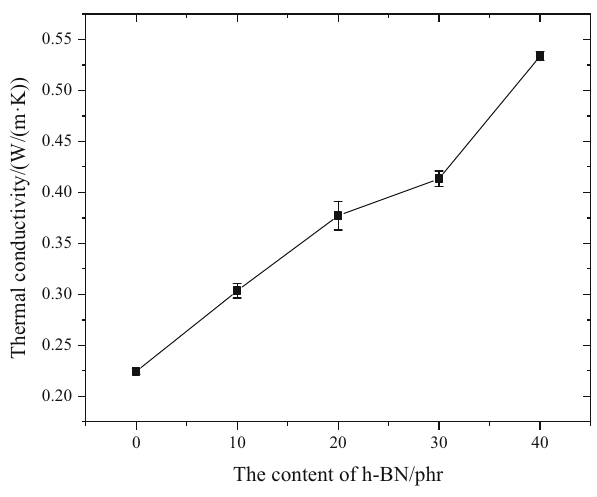
Figure 5: ThermalconductivityofEPcompositeswithdi ff erenth -